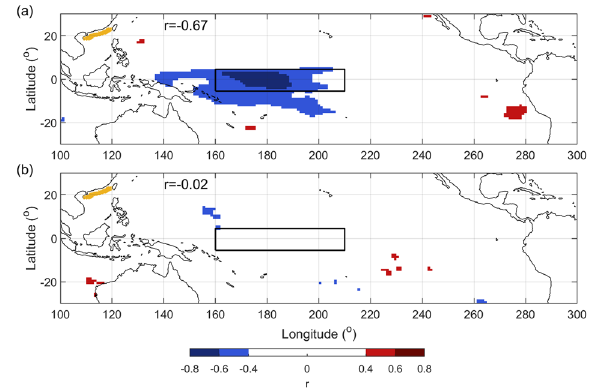
Fig. 2 Correlation of tropical Paci fi c summer subsurface ocean temperature and SST with following year ’ s South China landfall counts. landfall counts and the preceding year ’ s June – August (JJA-1) a 100 – 300 m subsurface ocean temperature, and b sea surface temperature. The correlation coef fi cient for each variable averaged across the black box (Niño 4) is shown. Correlations signi fi cant at the 99% con fi dence level using a two-tailed t -test are shaded. Yellow markers show position of the landfall events in south